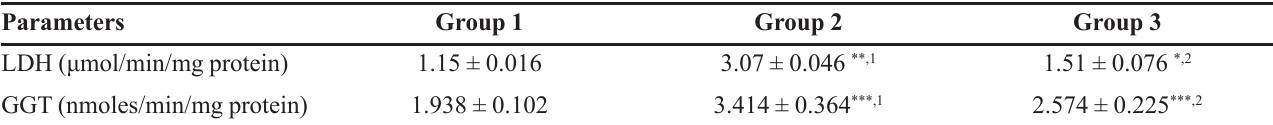
TABLE II - Effect of propolis on serum marker enzyme activities in the control and experimental animals